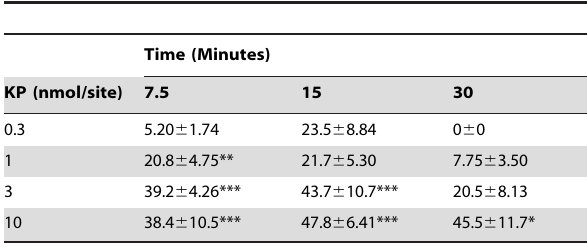
Table 1. Kisspeptin-10 mediated oedema formation is